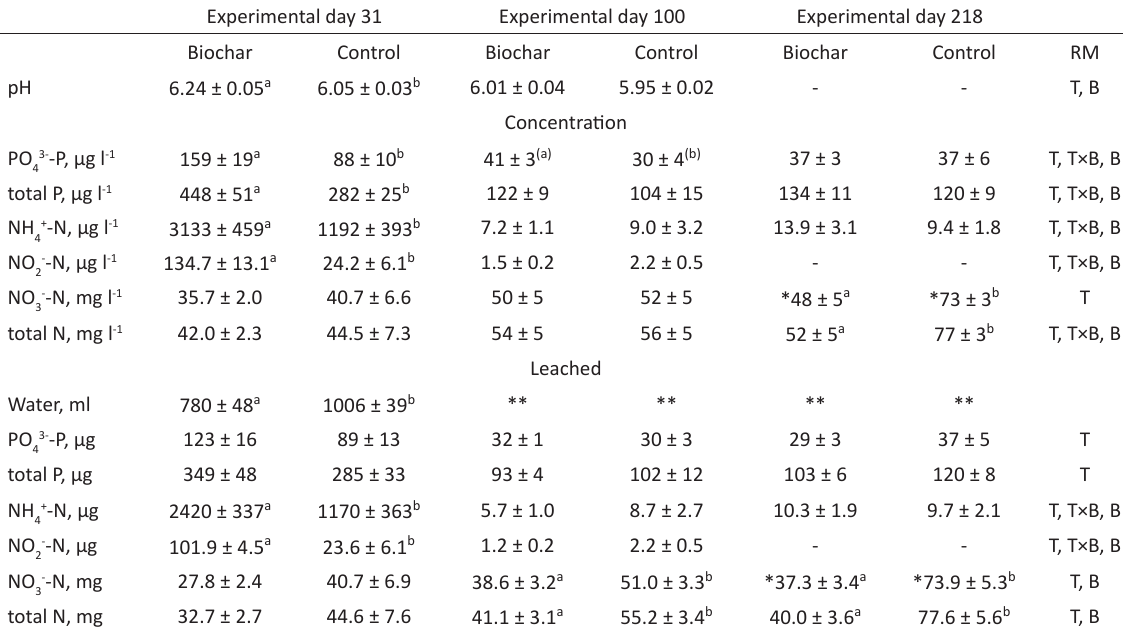
Table 3. Mean (± standard error of mean) concentration in the leached water and the amount of leached nutrients during three sampling occasions on the sandy till soil. Small letters indicate significant ( p < 0.05) or in parenthesis indicative (i.e. 0.05 ≤ p < 0.10) differences between biochar treatments during the experimental day in question. RM = repeated measures analysis, significant factors mentioned: T = time, B = biochar, T × B interaction of time and biochar, n = 6